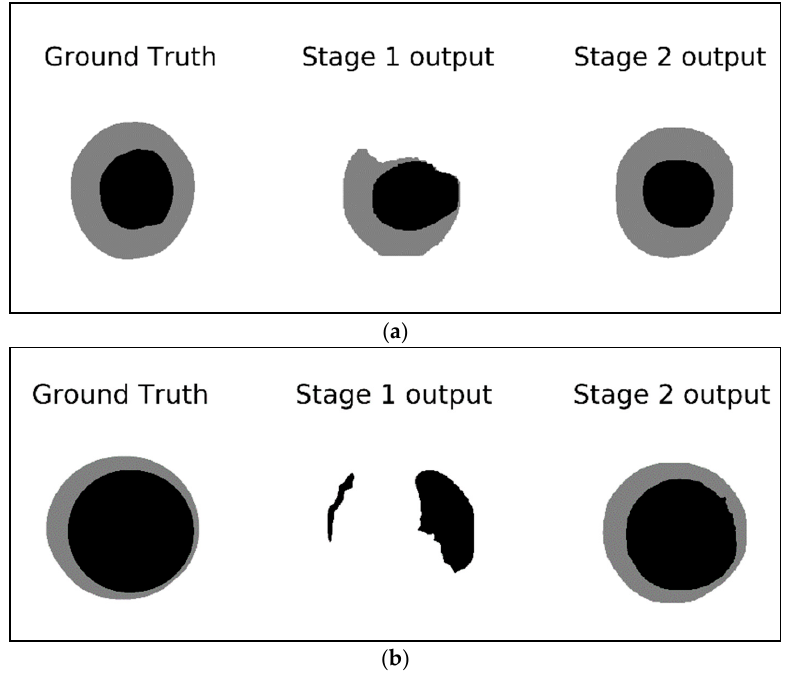
Figure 8. Example showing the ground truth, stage 1 output, and stage 2 output where ( a ) stage 1 output was inaccurate and ( b ) stage 1 output misses the entire cup and large part of the